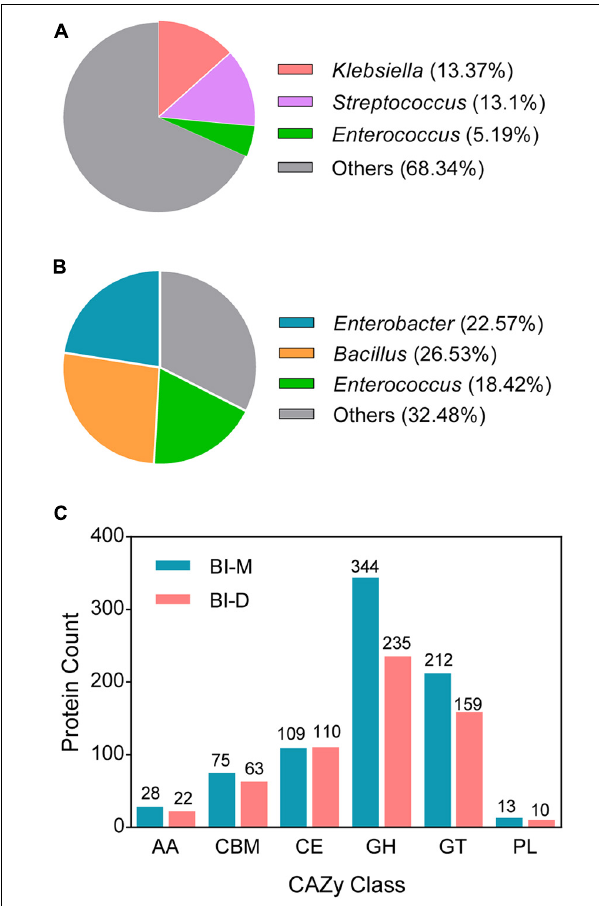
FIGURE 2 | Draft genomes of two microbial consortia from the gut of ECB larvae fed with an artificial diet (BI-D) and maize plants (BI-M) respectively. Panel (A) and panel (B) represent the relative abundance of the dominant bacteria in BI-D and BI-M respectively. (C) The number of CAZyme genes defined in the draft genomes of BI-D and BI-M.